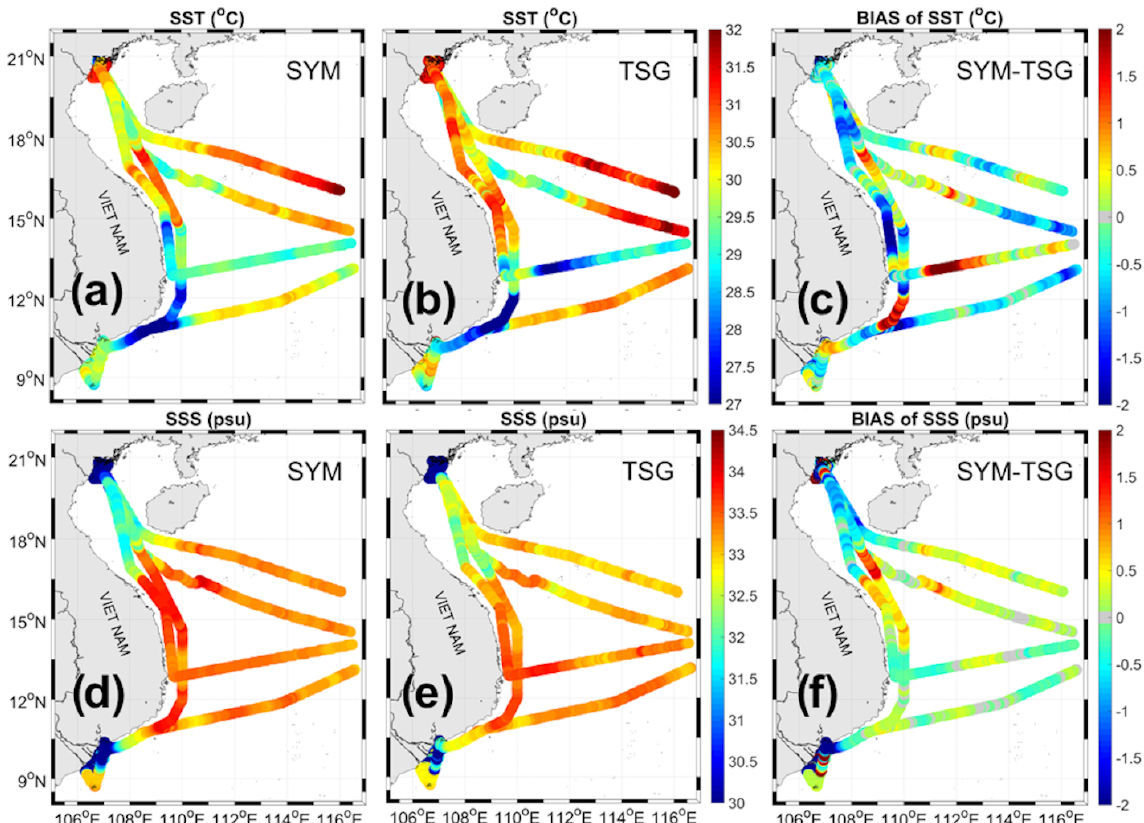
Figure 9. Values of SST (top) and SSS (bottom) from (a, d) ALIS-TSG trajectory during summer 2014 and from (b, e) SYMPHONIE co-localized outputs and (c, f) bias between SYMPHONIE and